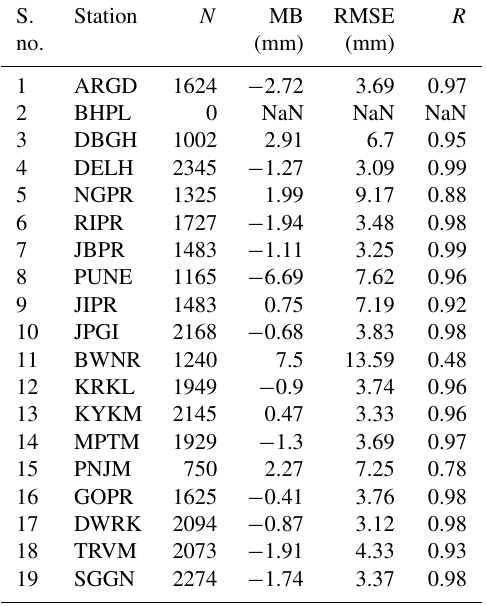
tively. The desert station RMSE, CC and bias are 3.37 mm, 0.98 and − 1.74 mm respectively (Table